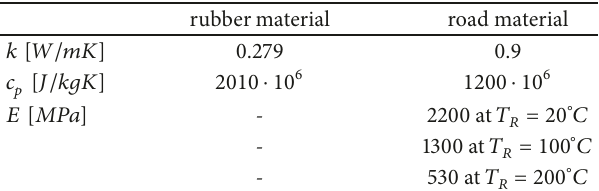
Table 2: Material properties in the simulation of a rubber block moving on a tire-rotation-like displacement